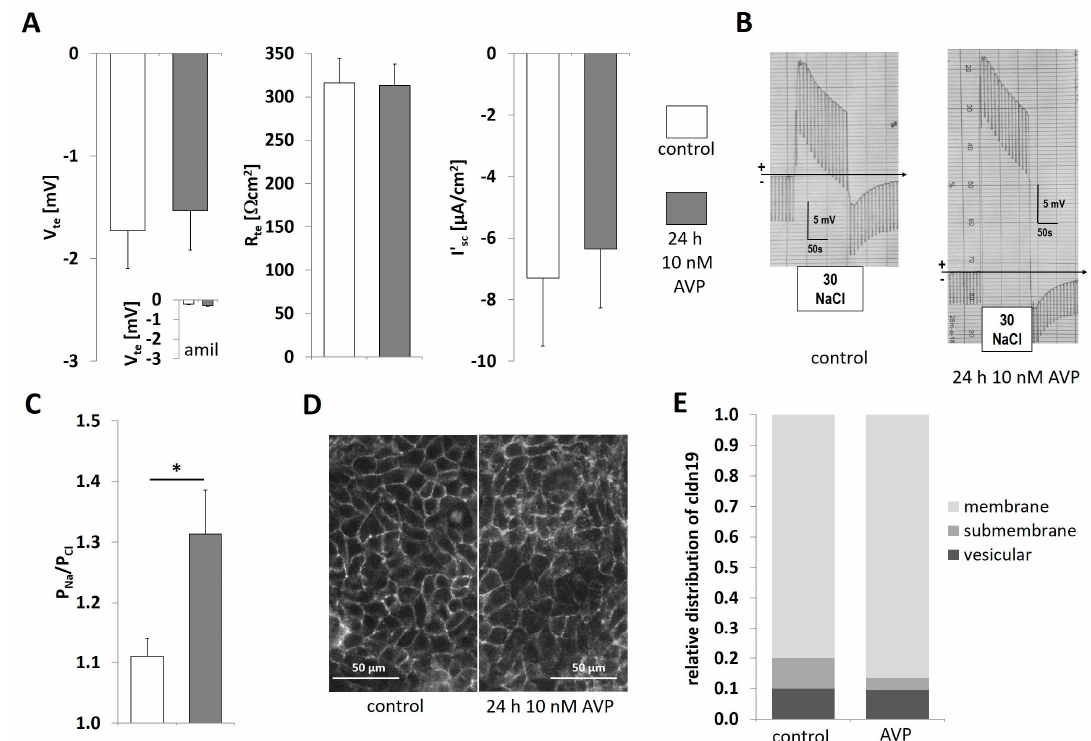
Figure 3. 300-IMCD under AVP stimulation (10 nmol / L). ( A ) Electrophysiological properties with transepithelial voltage V te , transepithelial resistance R te , and equivalent short-circuit current I’ sc , with or without 24 h prestimulation with AVP. Insert in V te panel: V te in the presence of 50 µ M amiloride. ( B ) Original experiments showing 30 mmol / L NaCl di ff usion potentials, ( C ) summarized permeability ratio PNa / PCl. Data are means ± SEM, n = 13,13; * p < 0.05. ( D ) Immunofluorescence of claudin-19 in 300-IMCD with or without 24 h prestimulation with AVP, ( E ) summarized subcellular localization of claudin-19 in the categories of membrane TJ staining, submembrane and intracellular vesicular staining, n = 13,